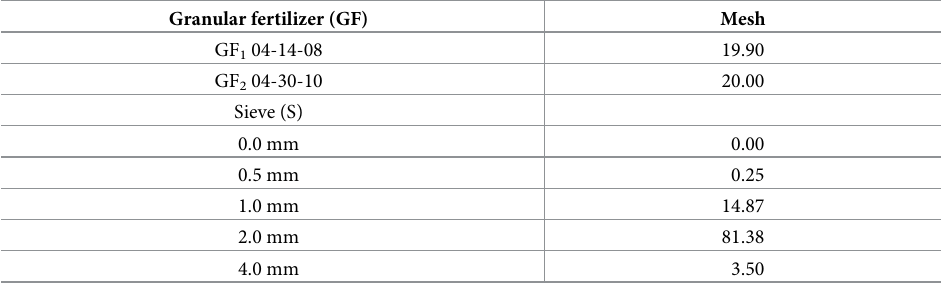
Table 3. Analysis of variance of the particle size of granular fertilizers.